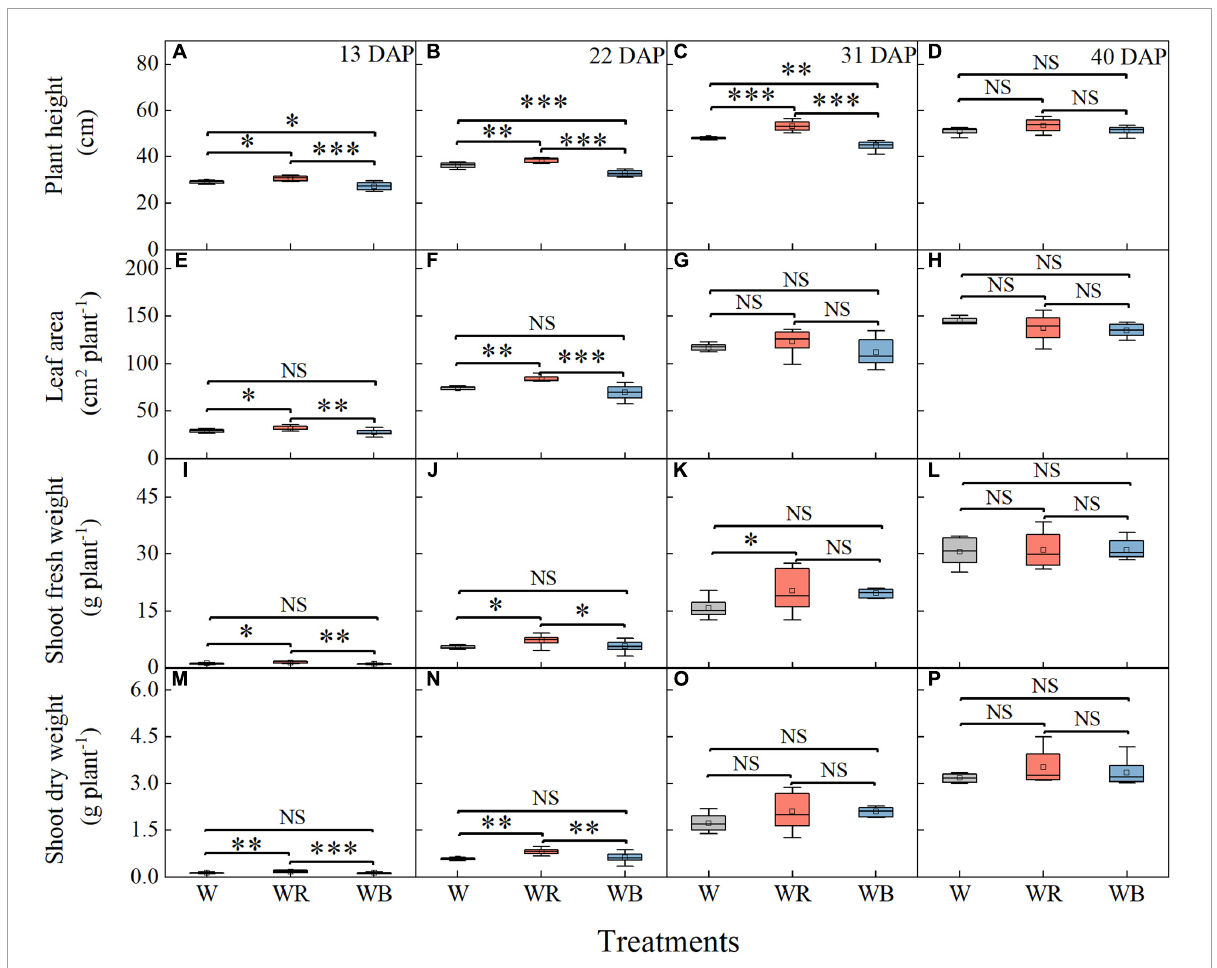
FIGURE2 Plant height (A–D) , leaf area (E–H) , shoot fresh weight (I–L) , and shoot dry weight (M–P) of wheat seedlings under different treatments at 13, 22, 31, and 40 days after planting (DAP). Values represent the mean ± SE ( n = 8). The symbols ∗ , ∗∗ , and ∗∗∗ indicate significance at the 0.05, 0.01, and 0.001 levels, respectively. NS, not significant, according to the Duncan’s